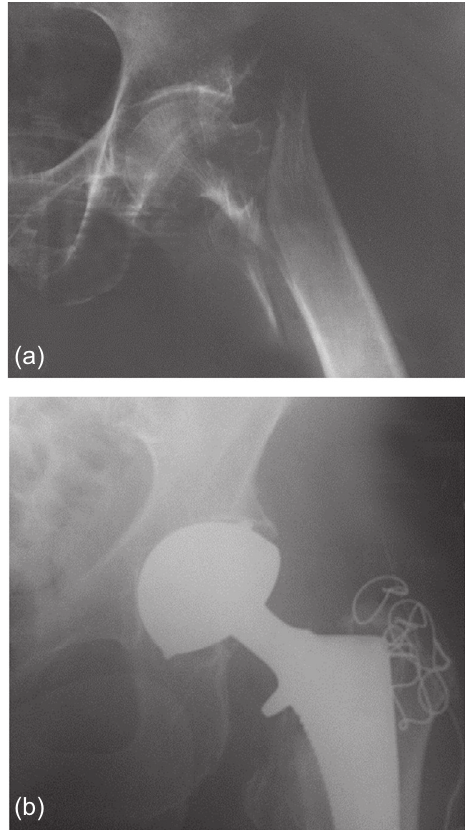
Figure 11. (a) ECTF left hip, (b) treatment by THA with DMC – perfect